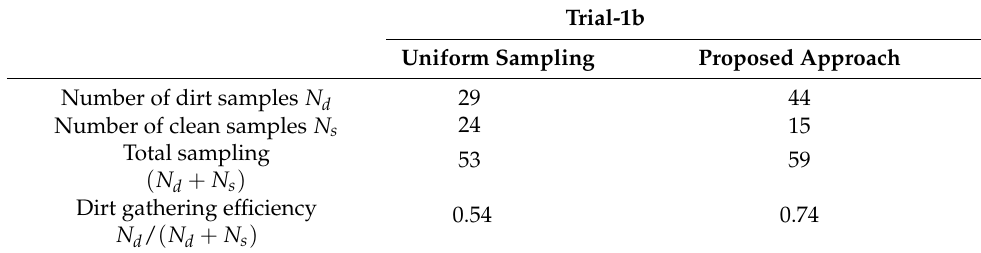
Table 2. The sampling efficiency for a dirt count threshold 10 in